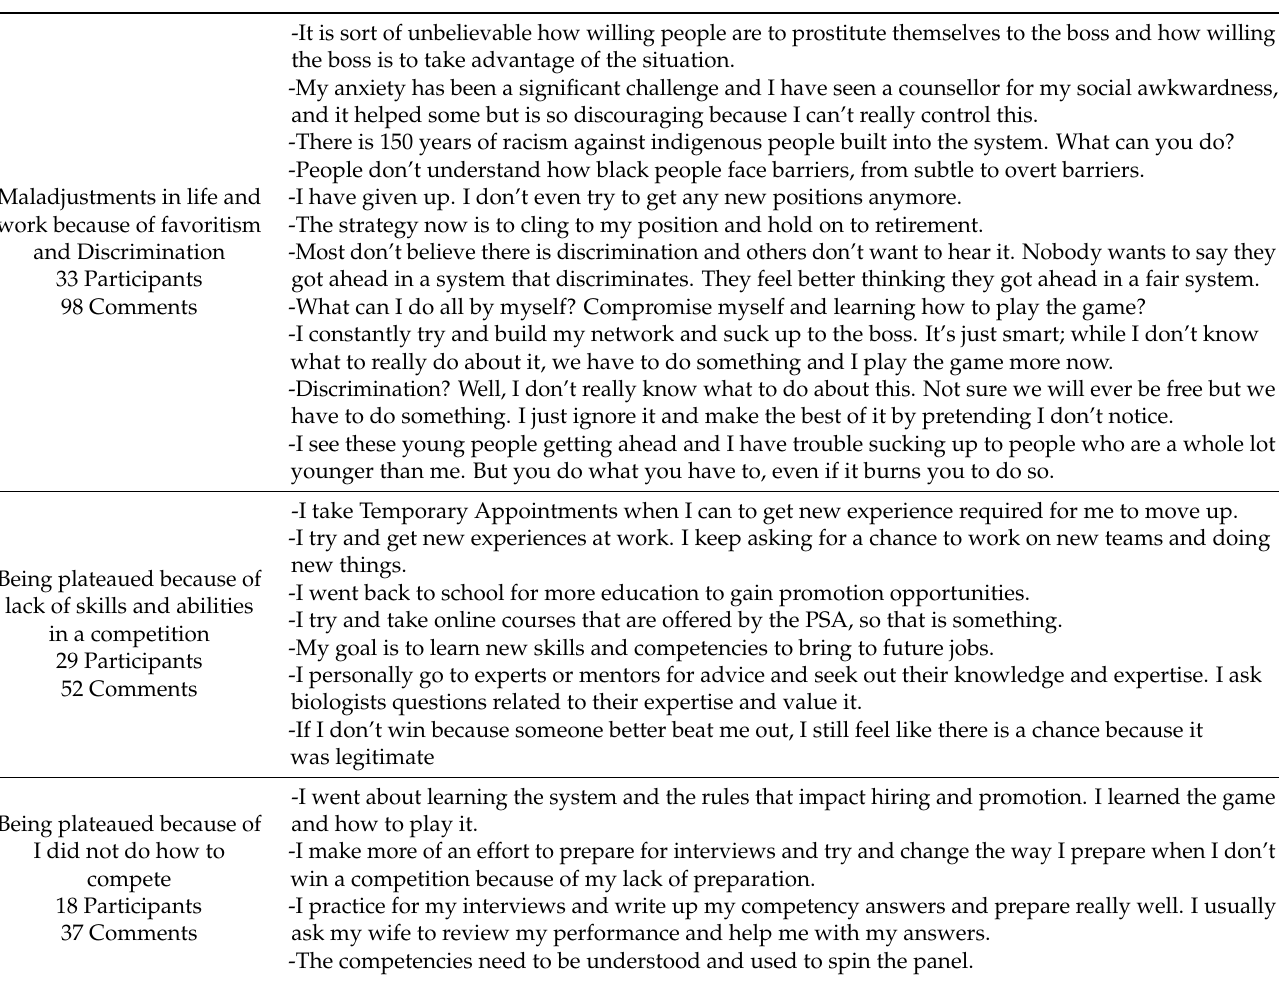
Table 4. Impacts of Being Plateaued (67 Study Participants contributing 187 Comments) N =